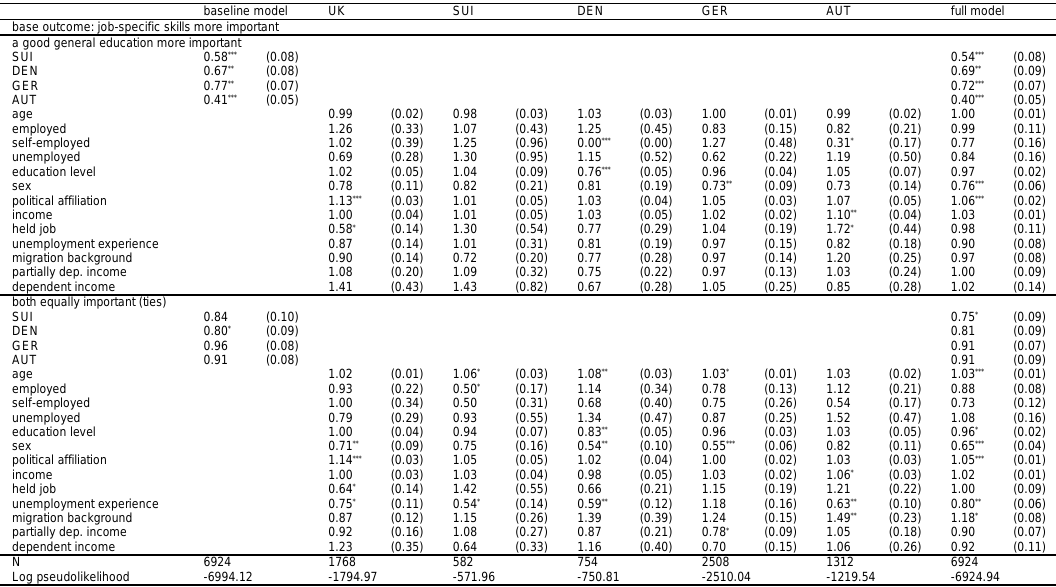
Table 4. Multinomial logistic models for the comparison of skill specificity. baseline model UK SUI DEN GER AUT